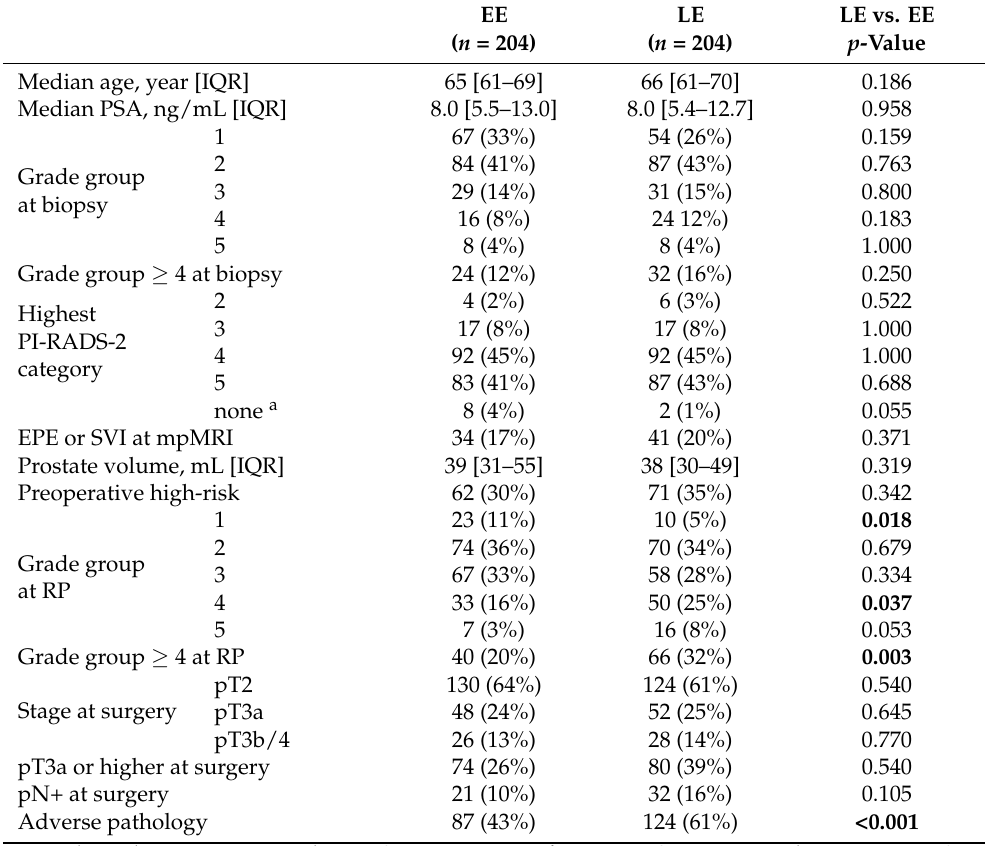
Table 1. The comparison of patient